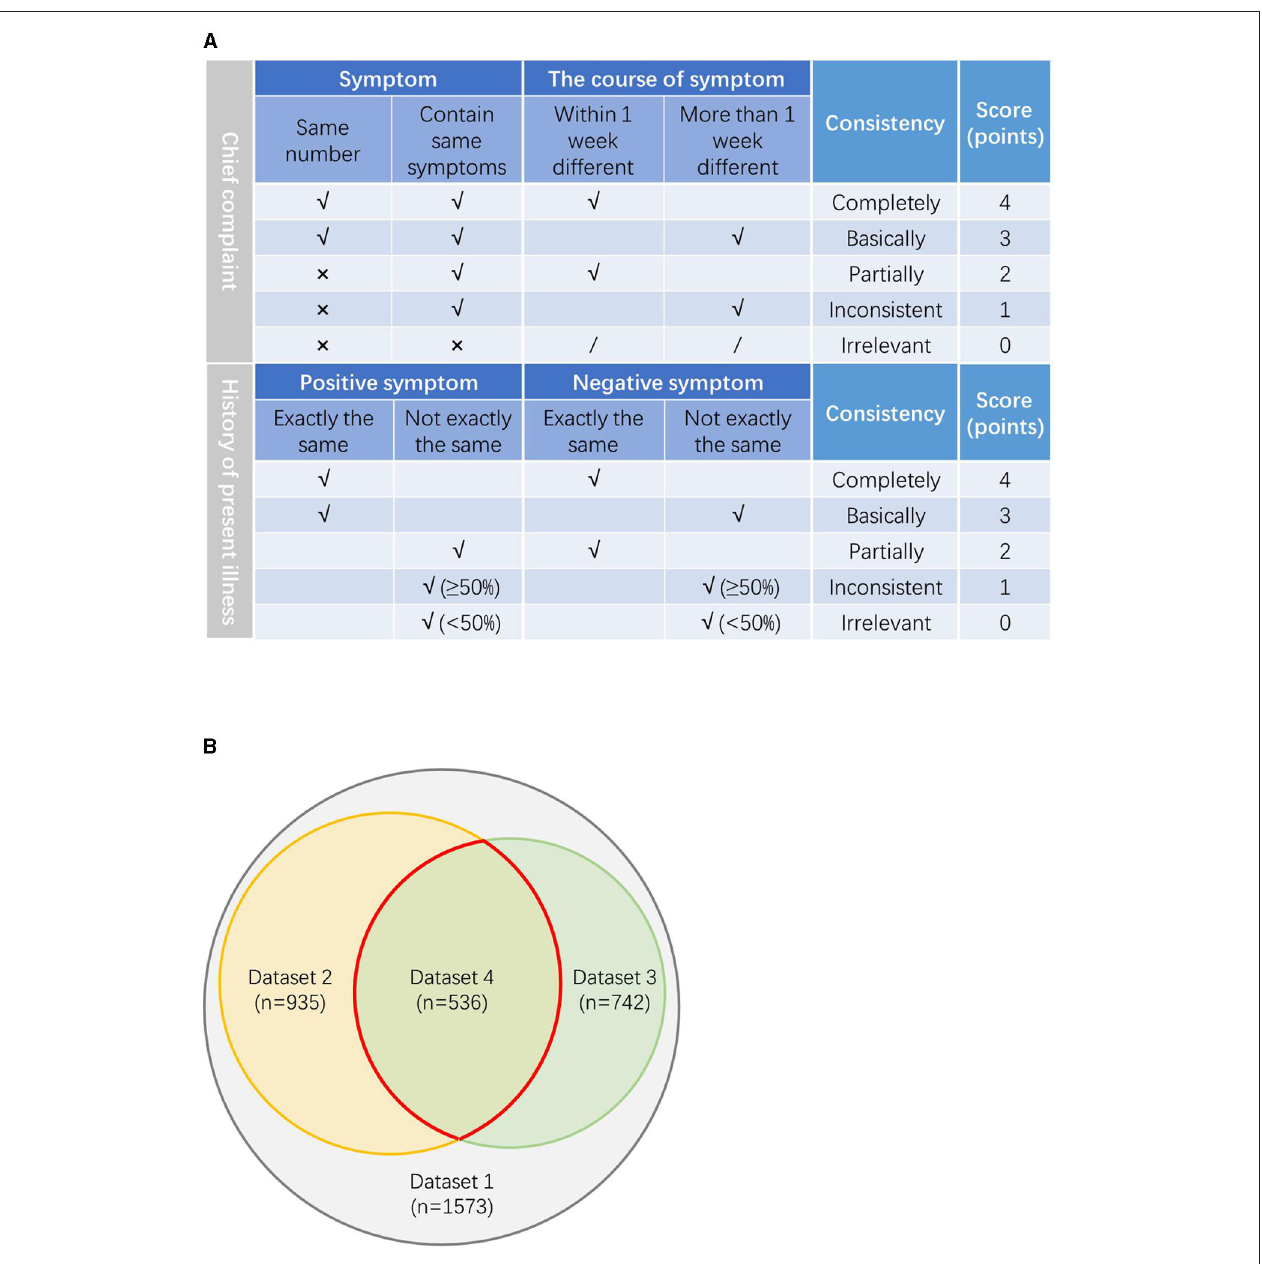
FIGURE 2 | (A) The evaluation rules on the consistency between the chief complaint and the history of present illness (HPI) described by our model and physicians. (B) The relationship between the datasets.